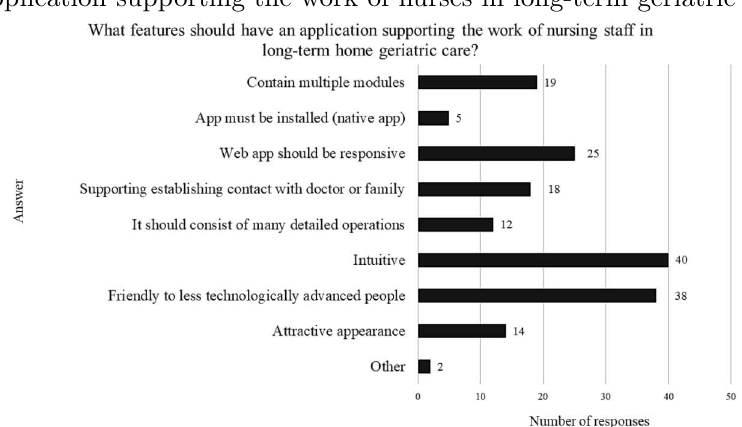
Figure 1. Desired application